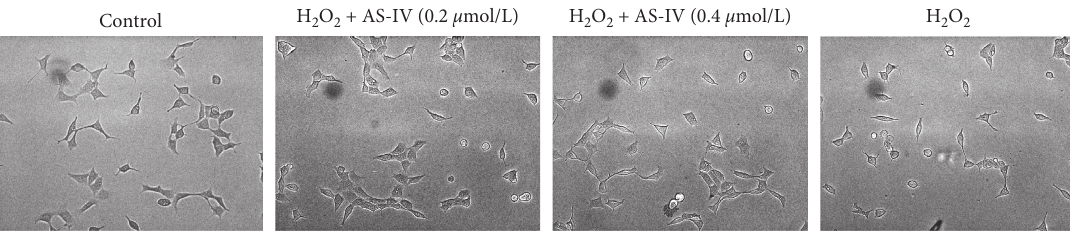
Figure 2: Morphological observation of SH-SY5Y cells under H pretreatment for 2 h.